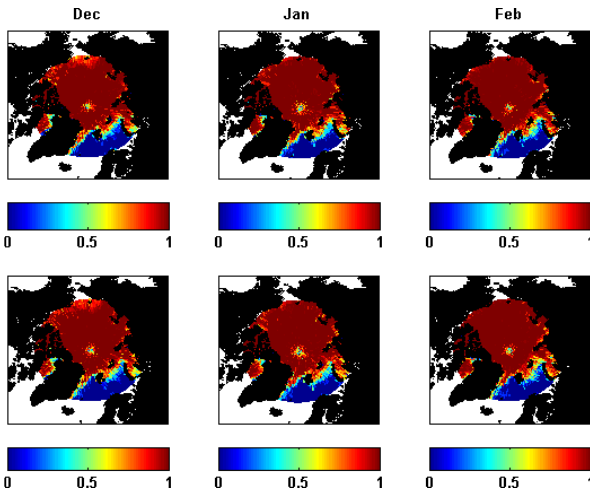
Fig. 1. The mean inversion frequency (averaged over 2003–2008) for the summer months over the Arctic Ocean (70 ◦ N–90 ◦ N). Top and bottom rows are for the ascending and descending passes.